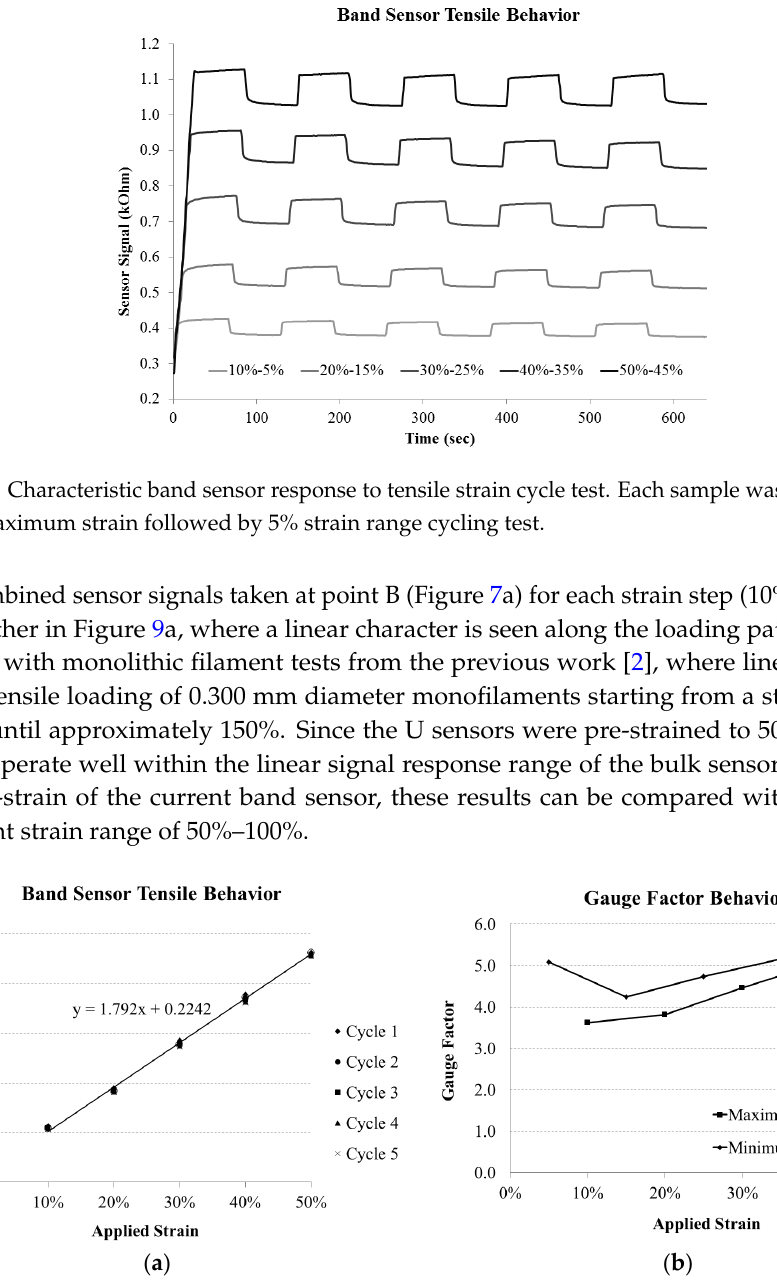
Figure 9. Characteristic band sensor signal tensile strain behavior ( a ) and gauge factor ( b ). The gauge